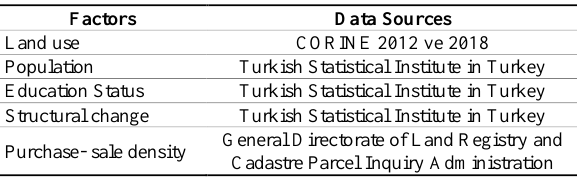
Table 2. Used macro data and data sources